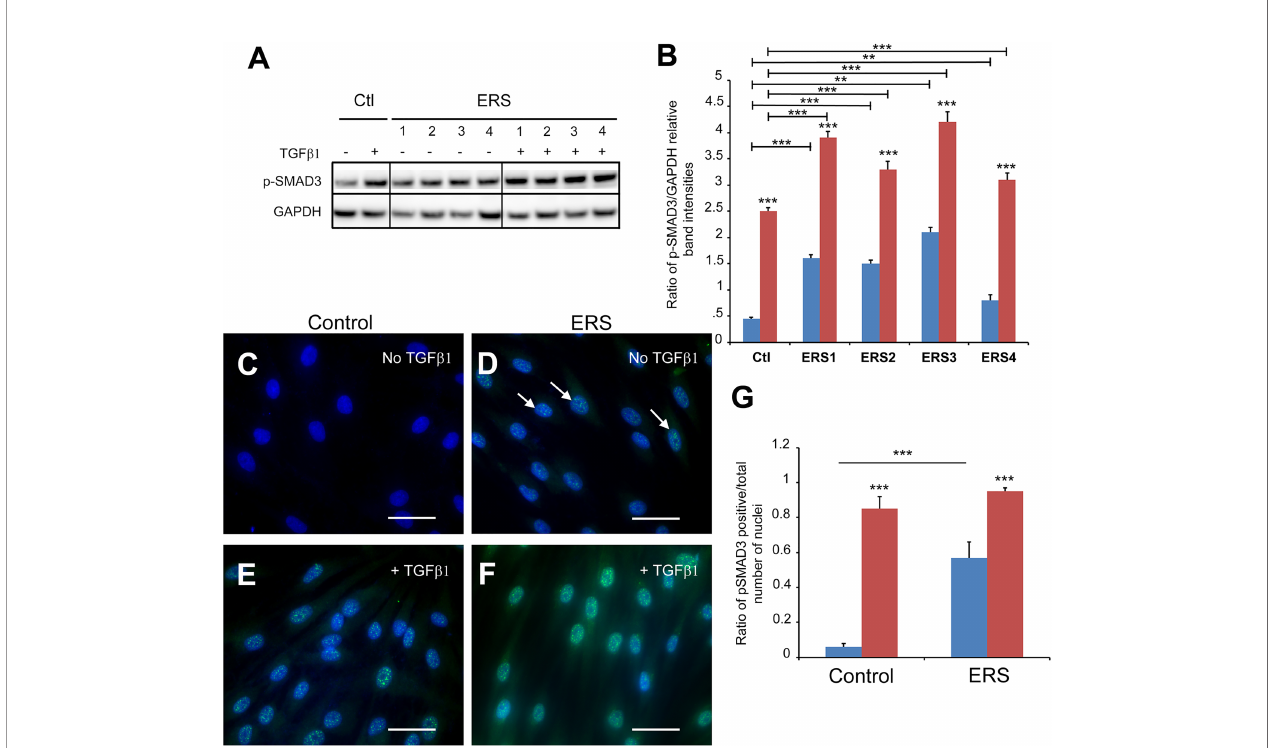
FIGURE 4 | SMAD3 activation in untreated ERS GFs and treated control and ERS GFs. GFs from control and ERS cultured without TGF b 1 (blue columns) or with TGF b 1 (5 ng/ml; red columns) for 6 hours. (A) Western blots were performed on cell lysates. P-SMAD3 protein levels were increased in control GFs cultured with TGF b 1. P-SMAD3 protein levels were increased in ERS GFs cultured without or with TGF b 1 compared to Control. (B) Densitometric analysis of Phospho-SMAD3 bands normalized to corresponding GAPDH bands. Data represent mean fold change in band intensity ± s.d. relative to GAPDH of 3 independent experiments in triplicates. Data was analyzed via two-way ANOVA with Bonferroni multiple comparisons test (**p < 0.01, ***p < 0.001). (C – F) Immunocytochemical staining of control (C, E) and ERS (D, F) GFs cultured without TGF b 1 (C, D) or with TGF b 1 (5 ng/mL) (E, F) for 6 hours. Cells were fl uorescently labeled for p-SMAD3 (green) and nuclei (blue). Co-localization of p-SMAD3 and nuclei indicate nuclear translocation of p-SMAD3. ERS photomicrographs is a representative of all ERS cultures. (G) Average ratios of p-SMAD3-positive GFs normalized to total number of cells per fi eld of view at 40X magni fi cation were quanti fi ed from 20 images per condition. Data represent mean ratio ± s.d. of 3 independent experiments in triplicates of three control GF cultures and the four ERS patient cultures. Data were analyzed using two-way ANOVA with Bonferroni multiple comparisons test (***p < 0.001). Scale bars: 50 m